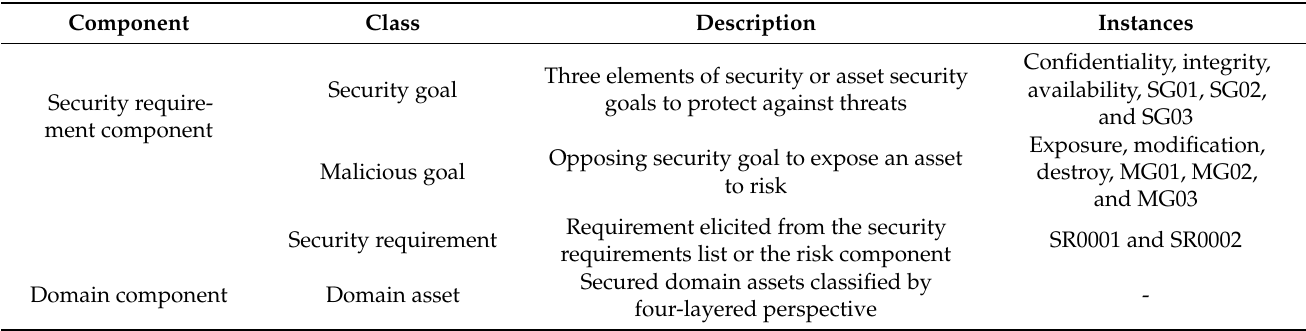
Table 3. Description of the security requirement and domain